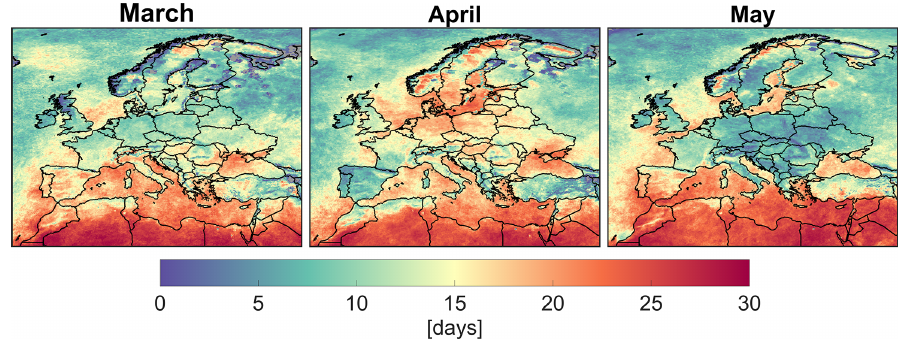
Figure 5. The average number of good quality (qa_flag > 0.75) TROPOMI tropospheric NO 2 days observed at 15 × 15km 2 in 2019 and 2020. These numbers are heavily affected by cloudiness.